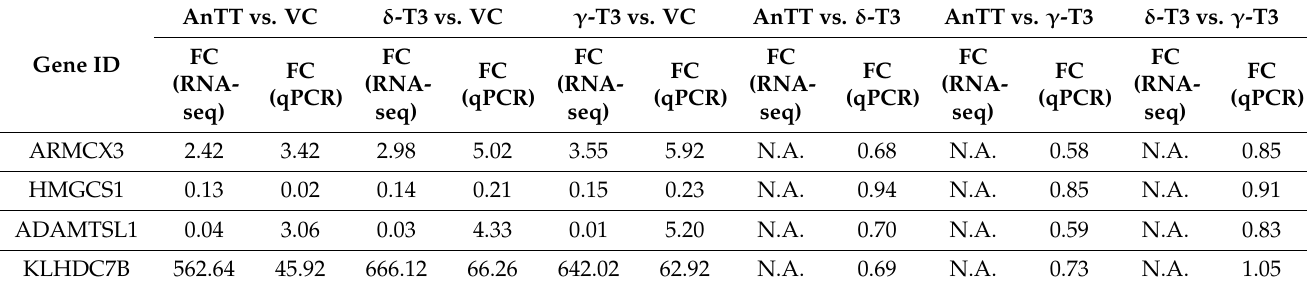
Table 1. Comparison of qPCR and RNA sequencing data in FC values for 4 target